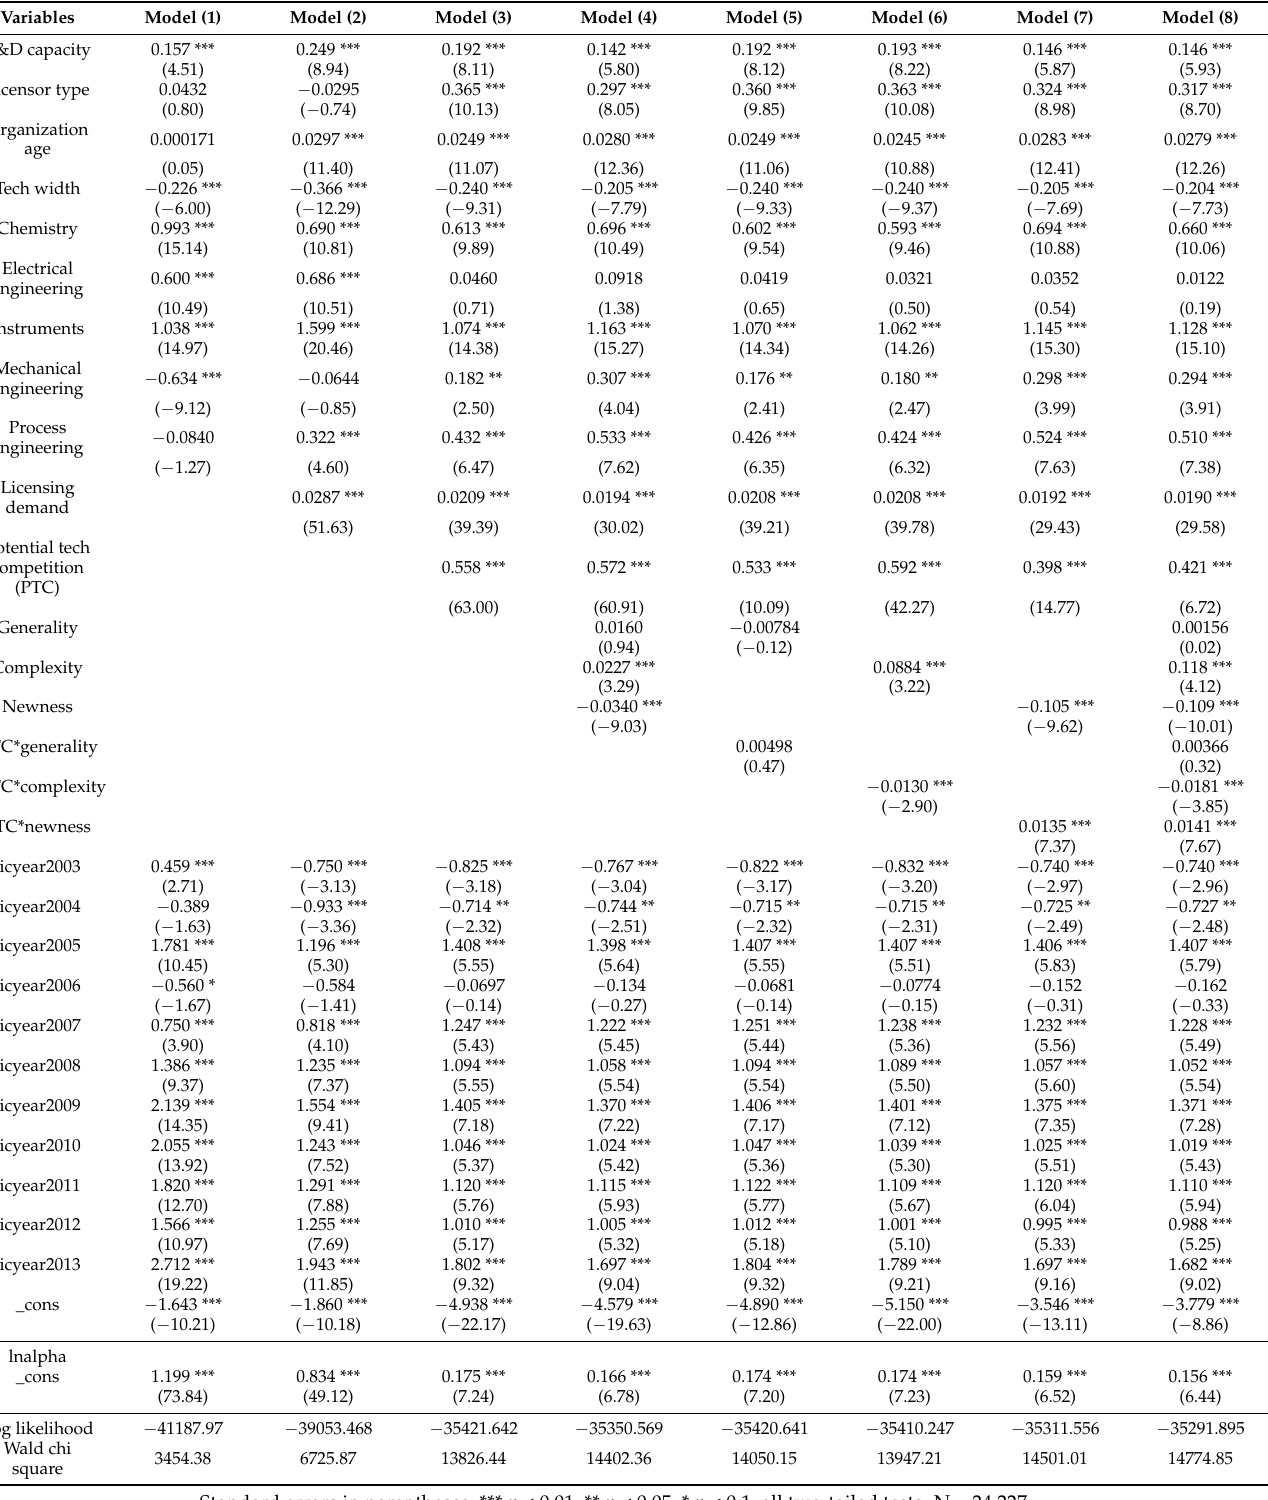
Table 2. Negative binomial regression